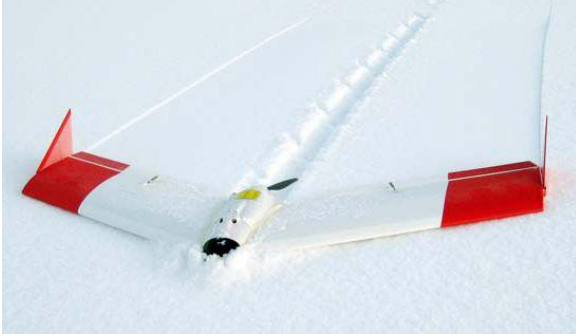
Figure 5 PAMS landed in snow – winter operations,